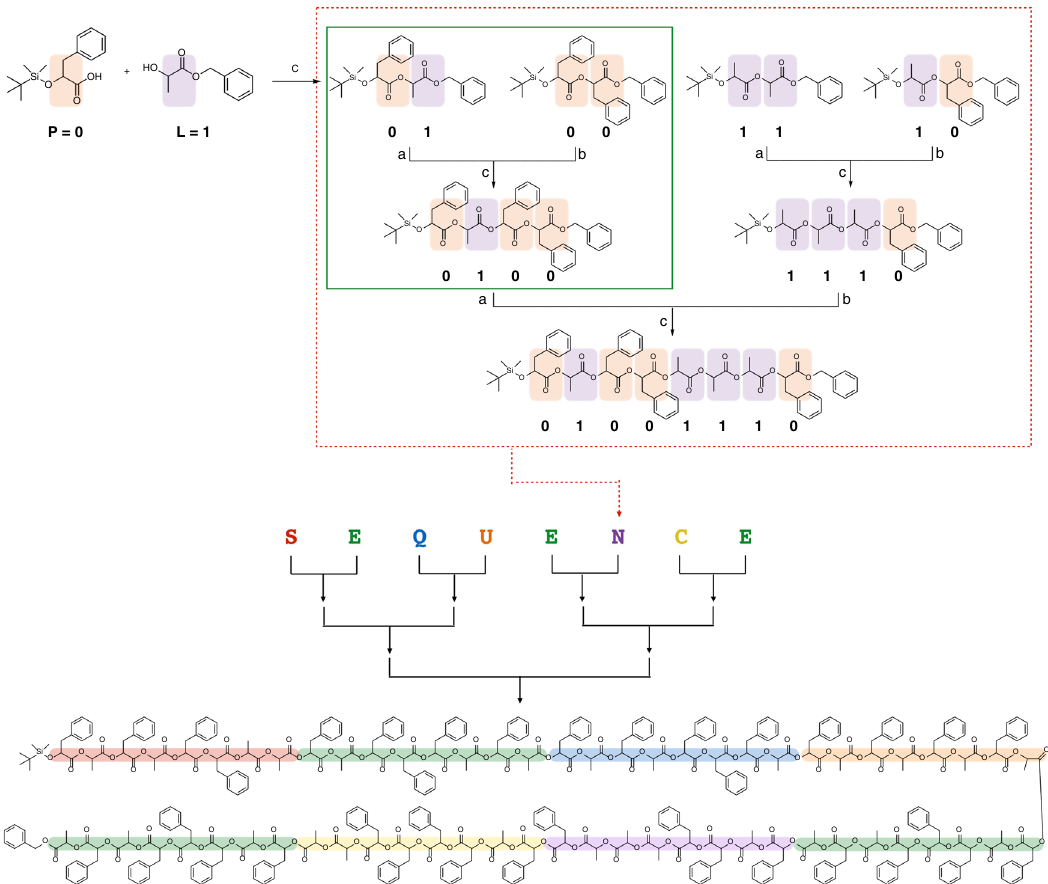
Fig. 1 Writing information in sequence-de fi ned PcL. Schematic illustration of the cross-convergent strategy to synthesize PcL with a sequence corresponding to the binary code for the 64-bit word SEQUENCE. Four dyads of phenyllactic acid (P representing 0) and lactic acid (L representing 1) were used as the constituent units of PcL. The cross-convergent pathway with four dyads could express any aperiodic P and L sequence. Tetrads were sequentially converged to form one-byte characters (shown in a red box), two-and 4-byte words, and fi nally PcL containing the 64-bit digital information encoding SEQUENCE. The green box indicates a set of deprotections and coupling constituting a convergent growth ( a BF 3 ⋅ Et 2 O, RT, 6 h; b Pd/C, H 2 , RT, 8 h; c EDC ⋅ HCl, DMAP, 8